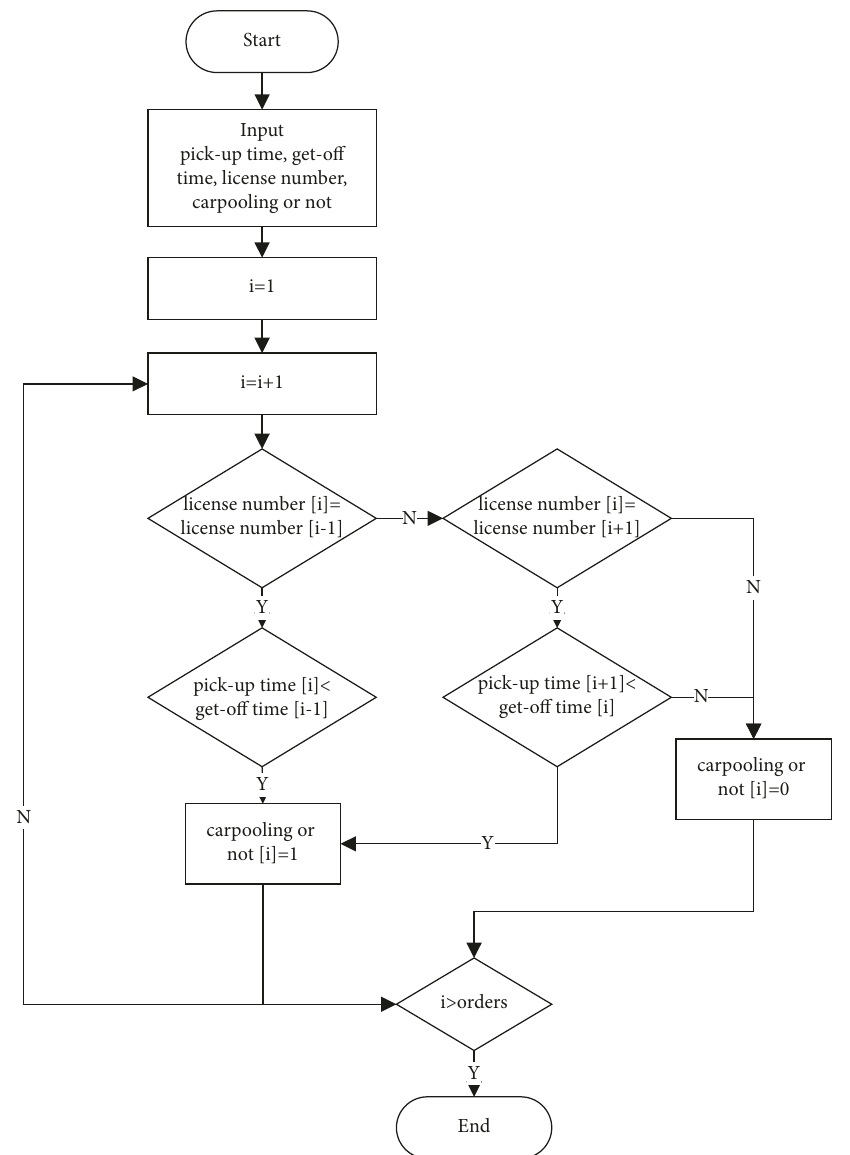
Figure 3: Flowchart of identifying ridesharing behavior of DR bus.